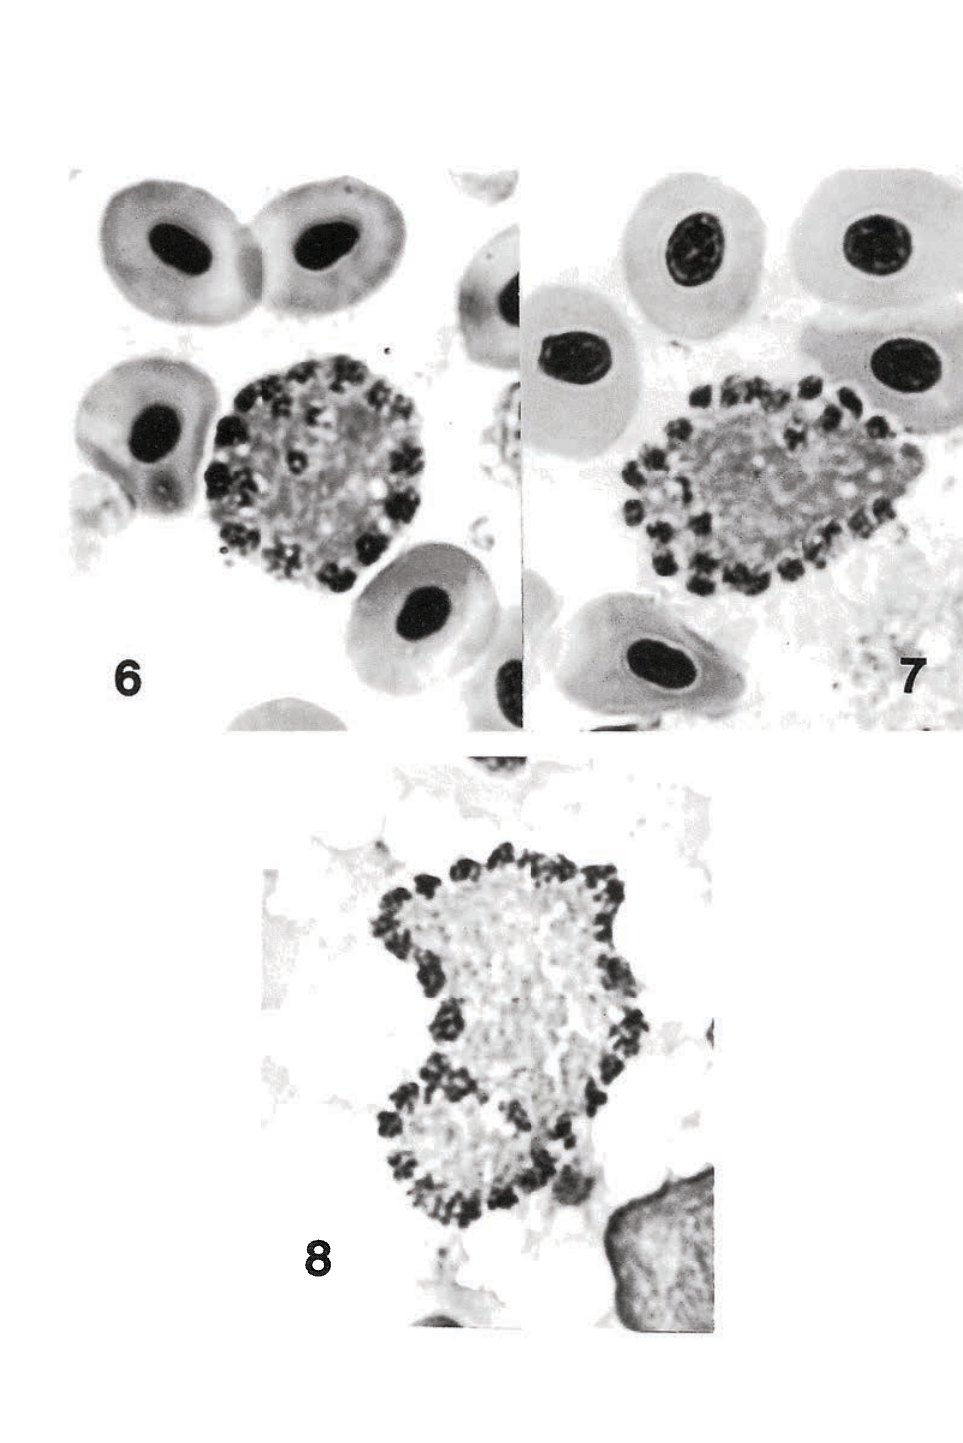
Figs 6-8. Merogony stages with chromatin aggregations shifted to the cell